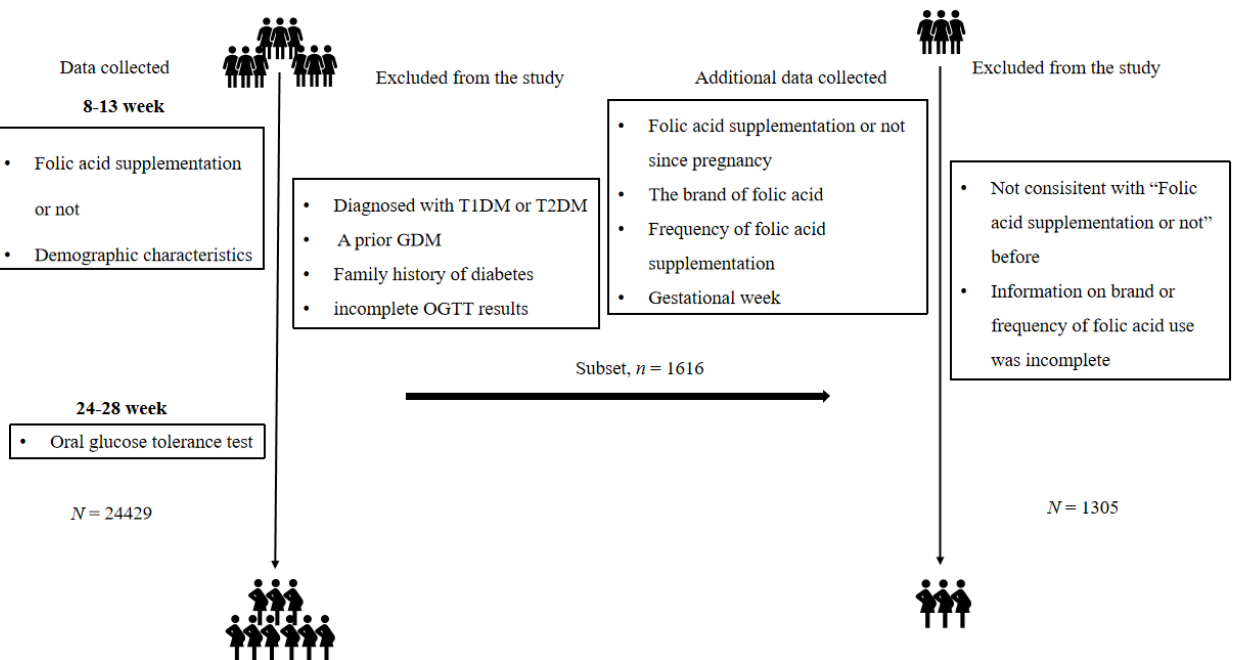
Figure 1. Study flowchart. T1DM, type 1 diabetes mellitus; T2DM, type 2 diabetes mellitus; GDM, gestational diabetes mellitus; OGTT, oral glucose tolerance test.